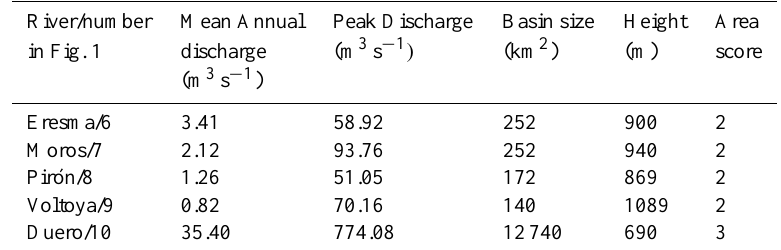
Table 2. Mean annual discharge and peak discharge of river sections in the Duero basin, showing the range of area used to calculate the quantitative indices. The locations of the gauging stations are shown in Fig.